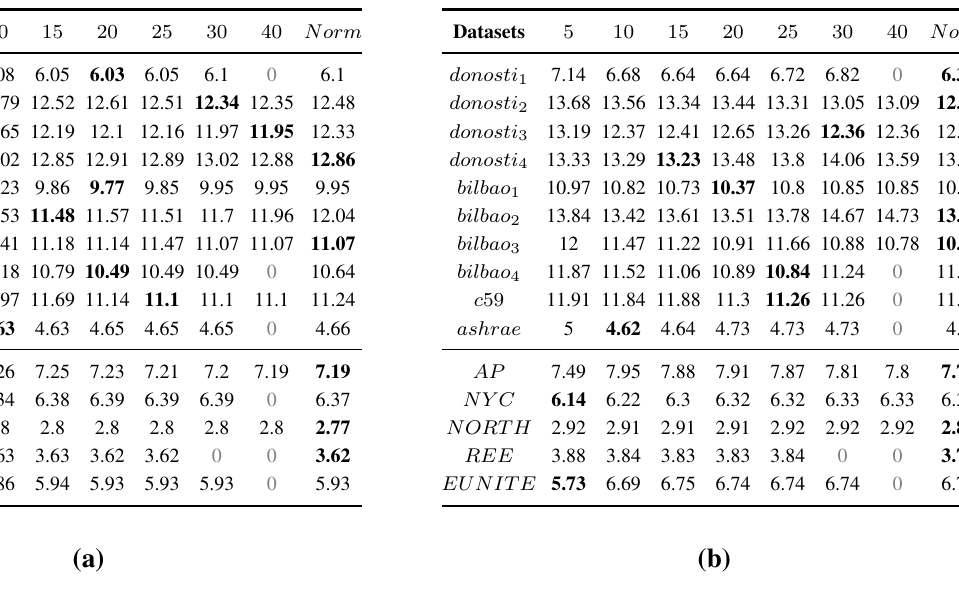
Table 4. MAPE results taking into account only the days when the post-process is working. Column Post-process shows the results using the post-process, while Column Normal shows the results without